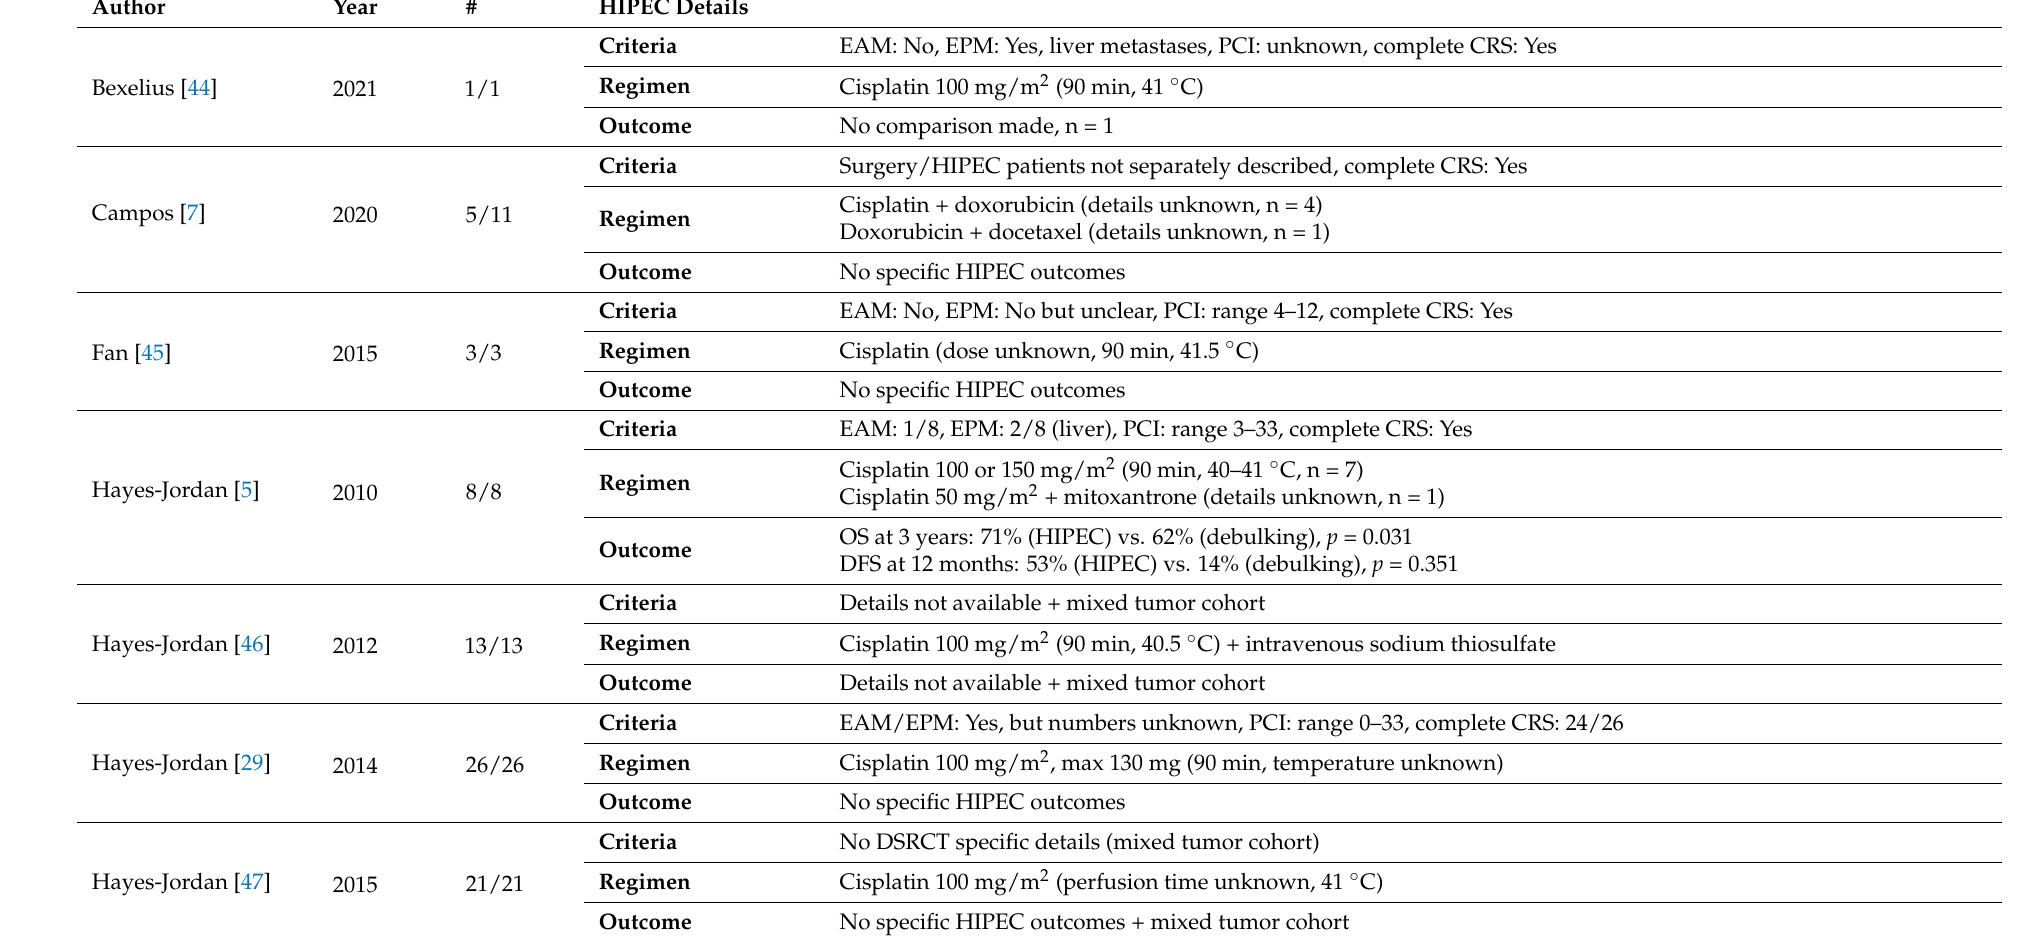
Table 3. Publications of HIPEC in